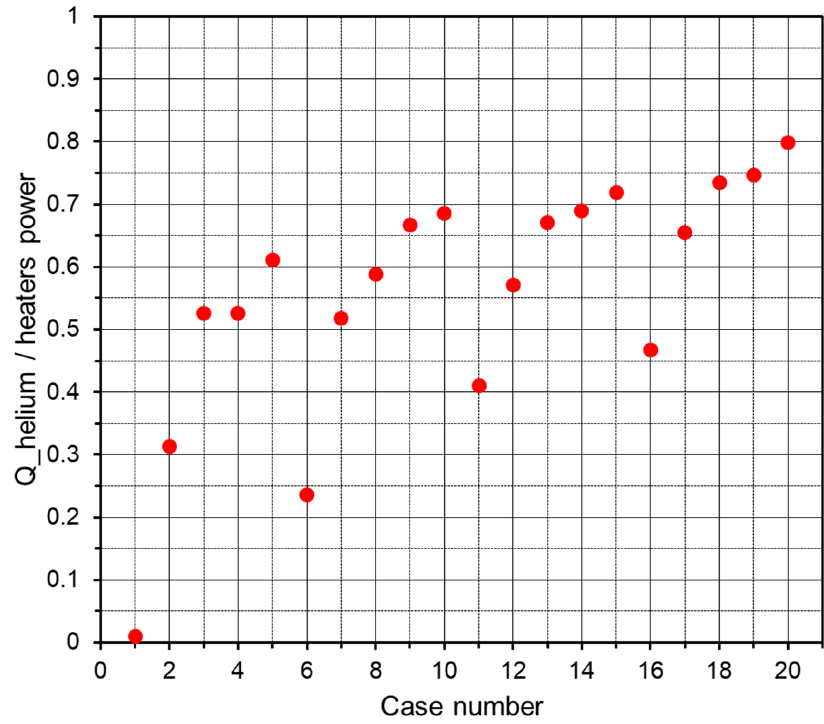
Figure 7. Heat absorbed by the coolant helium divided by the input heaters power.